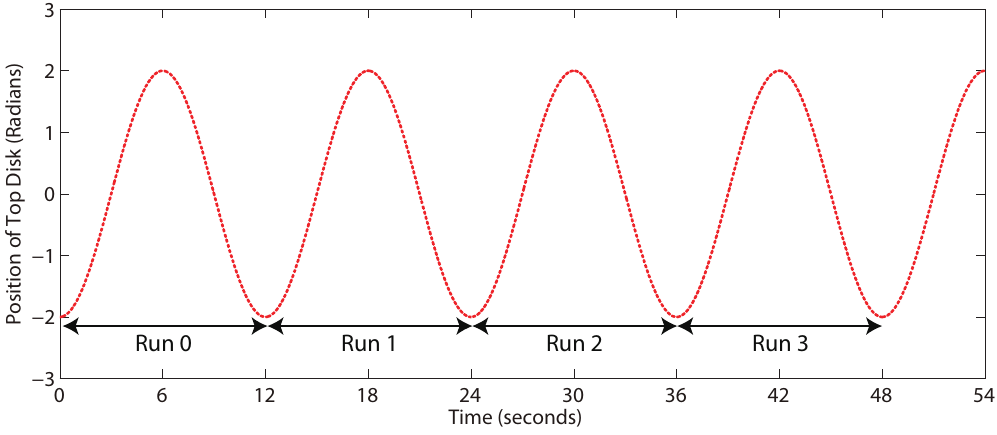
Figure 9. The generalization of “run-to-run” tuning to a system with a periodic setpoint trajectory. Only the setpoint is given